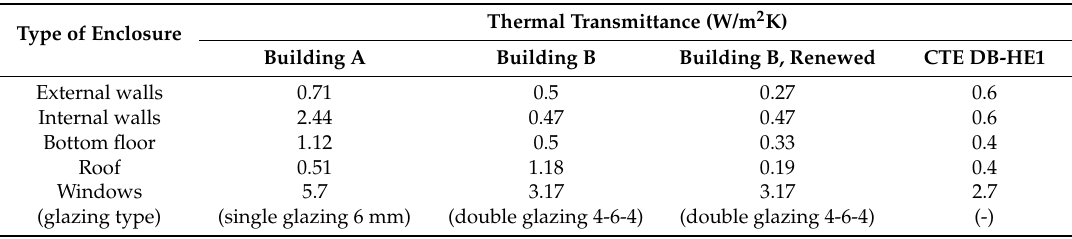
Table 3. Comparison of thermal-transmittance measurements of various enclosing areas of